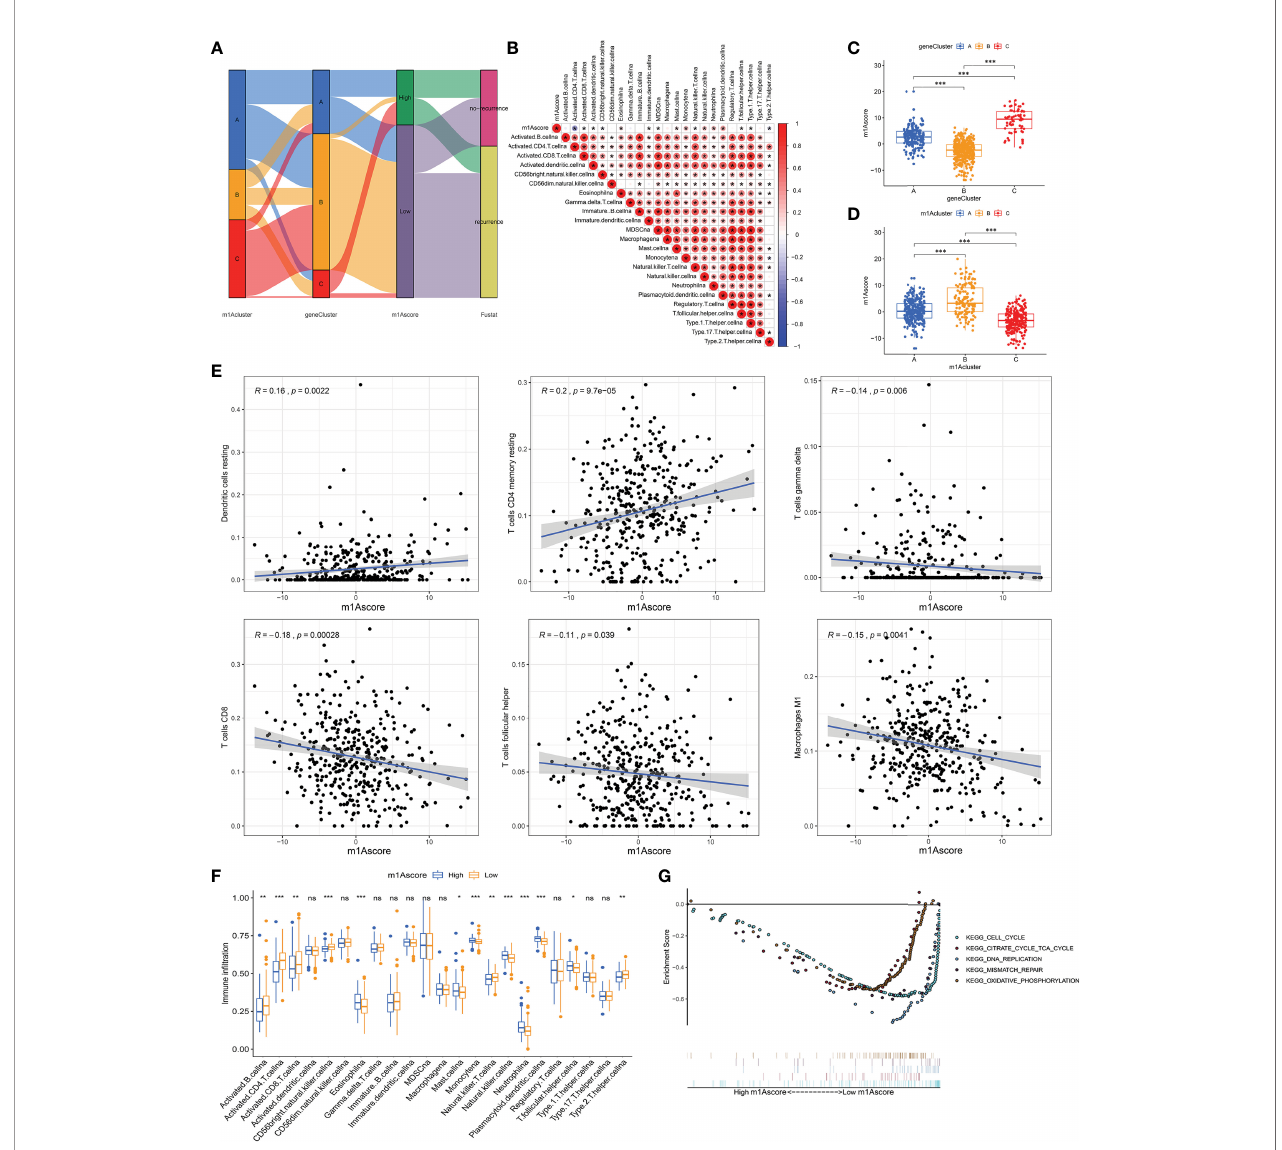
FIGURE 5 | Construction of m1A signatures. (A) Alluvial diagram showing the changes of m1Aclusters, gene cluster, m1Ascore and patient survival status. (B) Correlations between m1Ascore and the known gene signatures using Spearman analysis. Negative correlation was marked with blue and positive correlation with red. (C) Differences in m1Ascore among three gene clusters. (D) Differences in m1Ascore among three m1A modi fi cation patterns. (E) The correlation between m1Ascore and several immune cell, including resting dendritic cells, macrophages M1, resting memory CD4+ T cells, CD8+ T cells, follicular helper T cells and gamma delta T cells. (F) The abundance of each TME in fi ltrating cell in low- and high-m1Ascore group. (G) Enrichment plots showing cell cycle, citrate cycle TCA cycle, DNA replication, mismatch repair, and oxidative phosphorylation pathways were enriched in the low m1Ascore subgroup. *P < 0.05; **P < 0.01; ***P < 0.001. ns, not signi fi